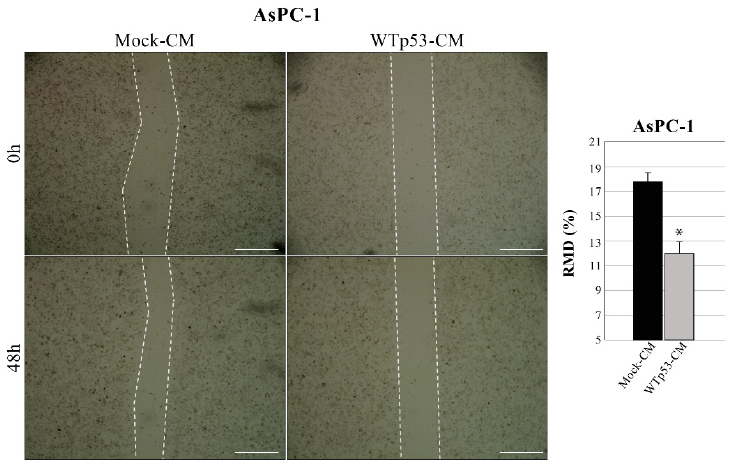
Figure 3. WTp53-driven secretome inhibits cancer cell migration. Wound closure cell assay on the confluent p53-null AsPC-1 cell monolayer cultivated with WTp53-derived conditioned medium (CM) as compared to CM derived from its mock control. A scratch was performed in the cell monolayer at time zero, after that we monitored cell migration for 48 h. The images were analyzed quantitatively by using ImageJ computing software. Migration ability expressed as relative migration distance (RMD) decreased in cells cultured with WTp53-derived CM. Statistical analysis * p < 0.05 CM-WTp53 vs. CM-Mock. Scale bar: 500 μ